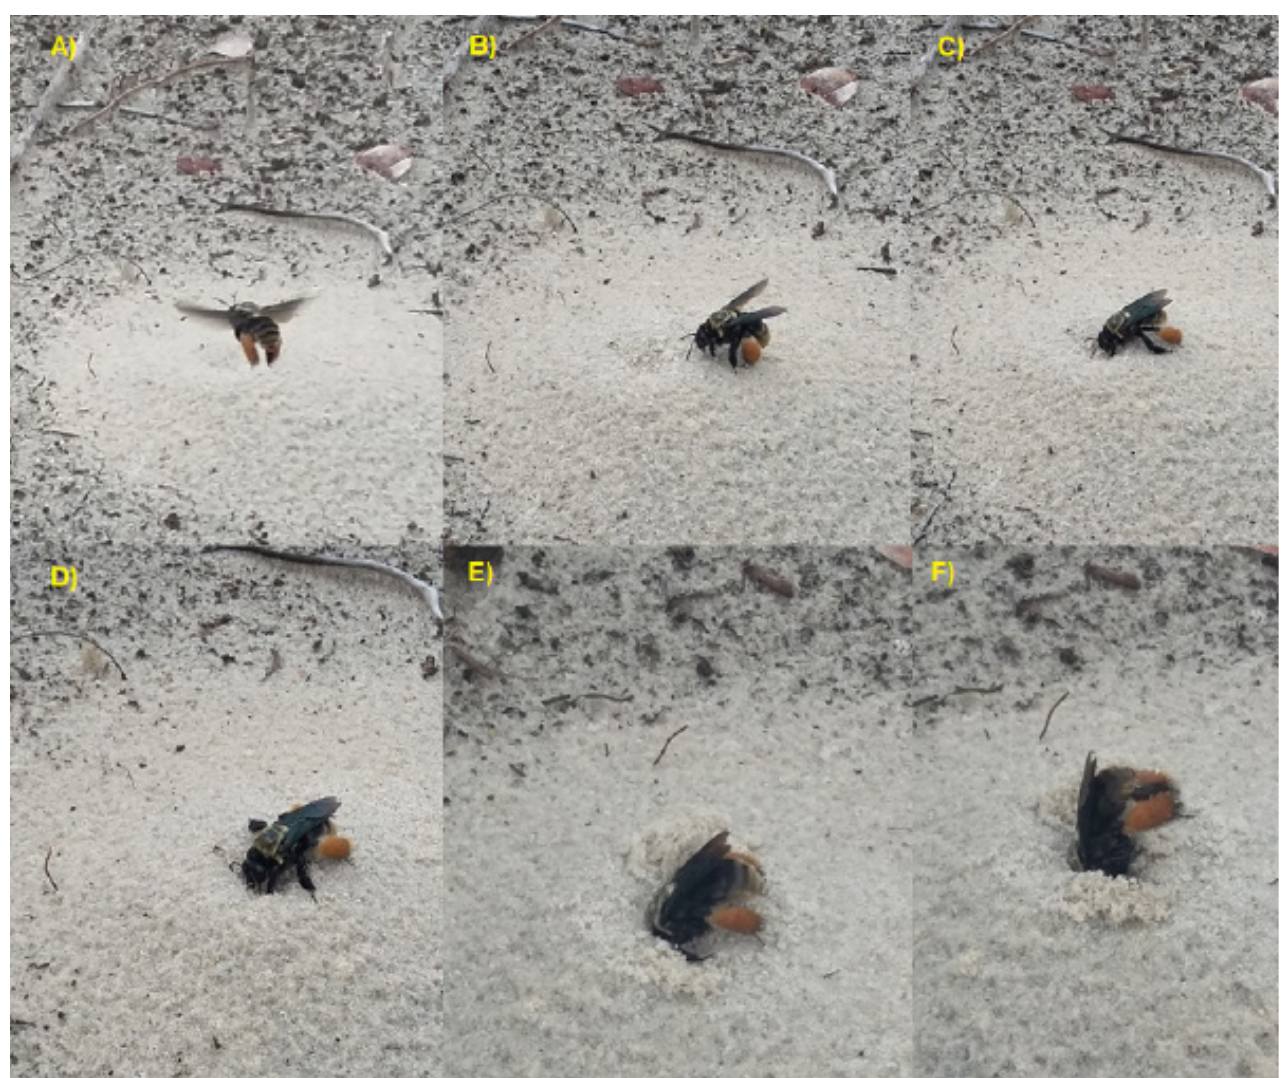
Figure S2. Sequence of images (A-F) showing moments of a nest re-excavation by a female of Epicharis dejeanii after a rainy period, which caused the obstruction of the nest